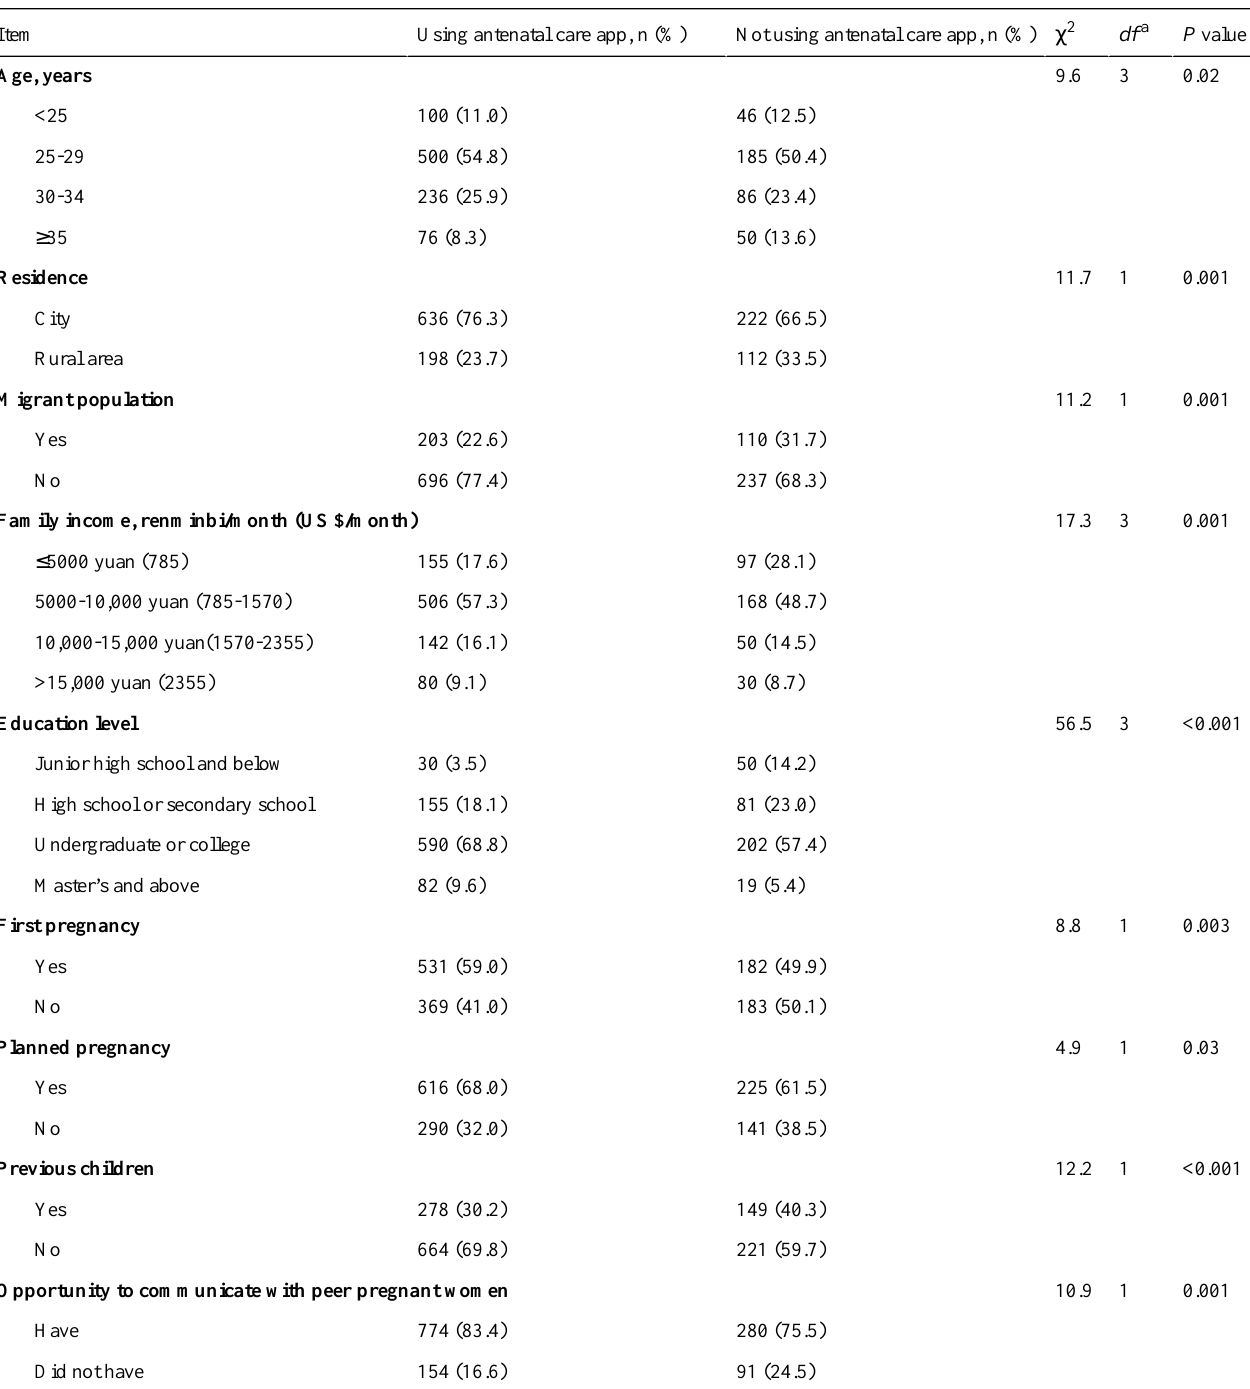
Table 2. Different usages of antenatal care apps among pregnant